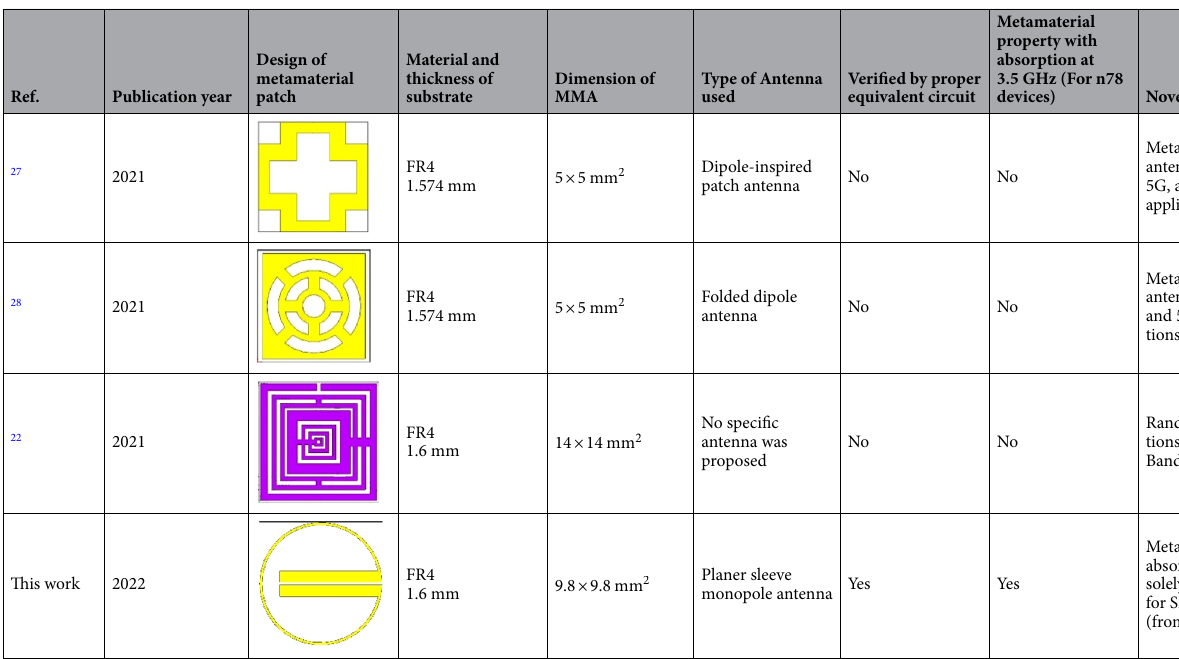
Table 3. Comparison of proposed MMA with relevant works for SAR